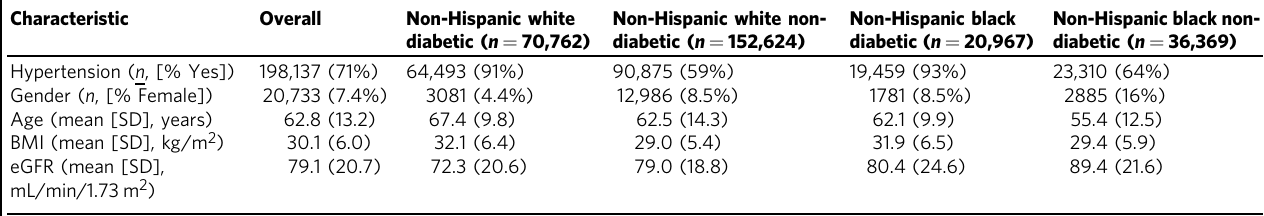
Table 1 Characteristics of Million Veteran Program discovery sample